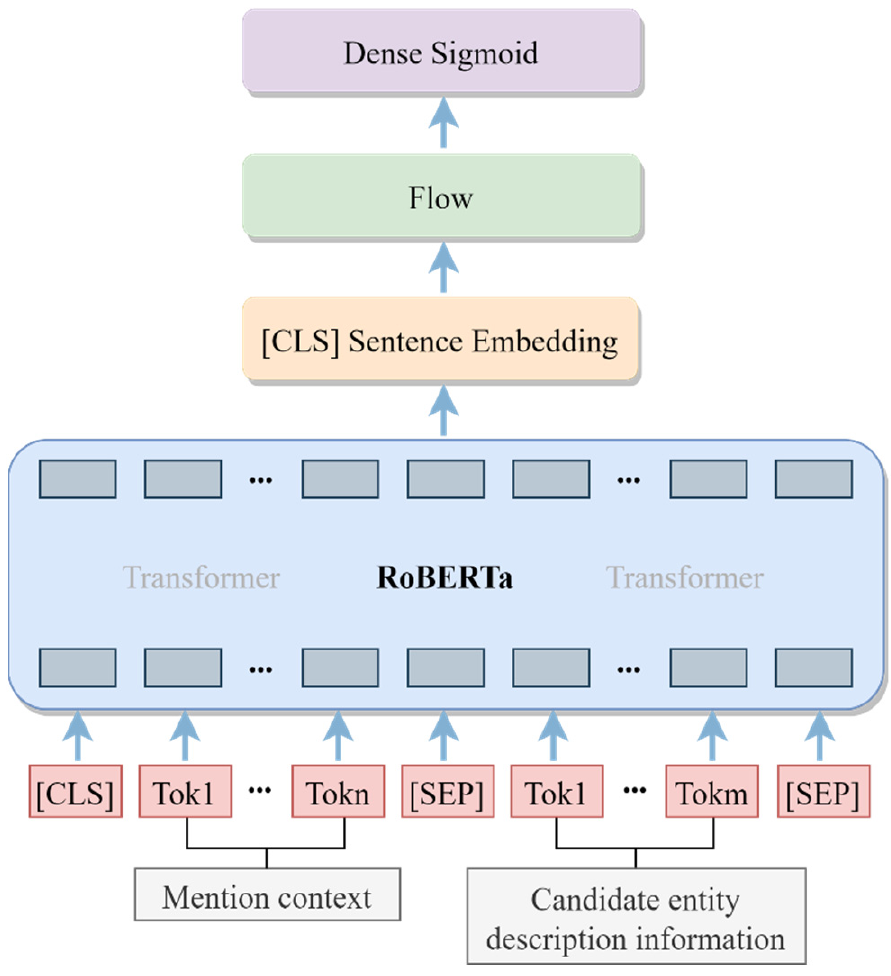
Figure 4. Entity ‐ linking